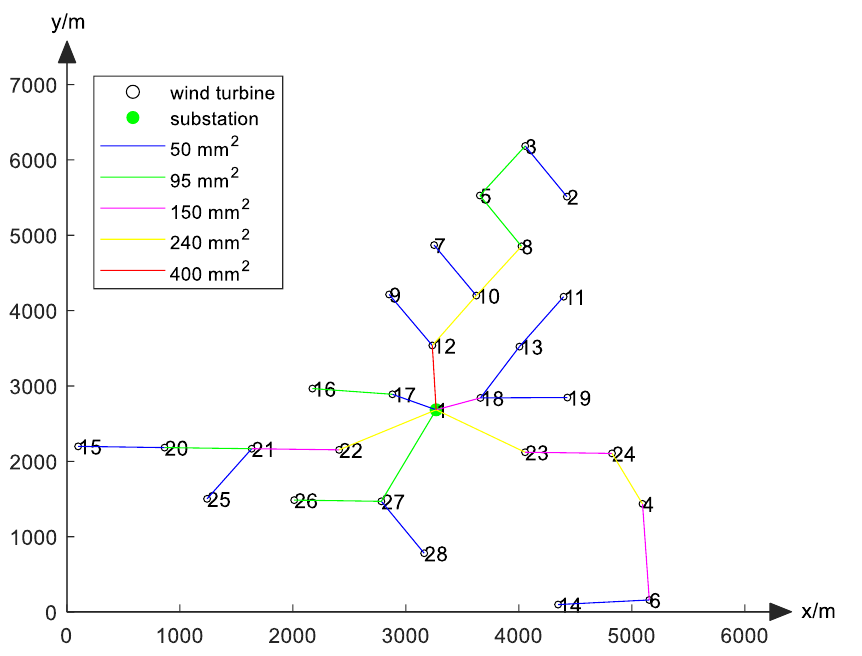
Figure 9. The topology of cables’ connection (variable substation location).